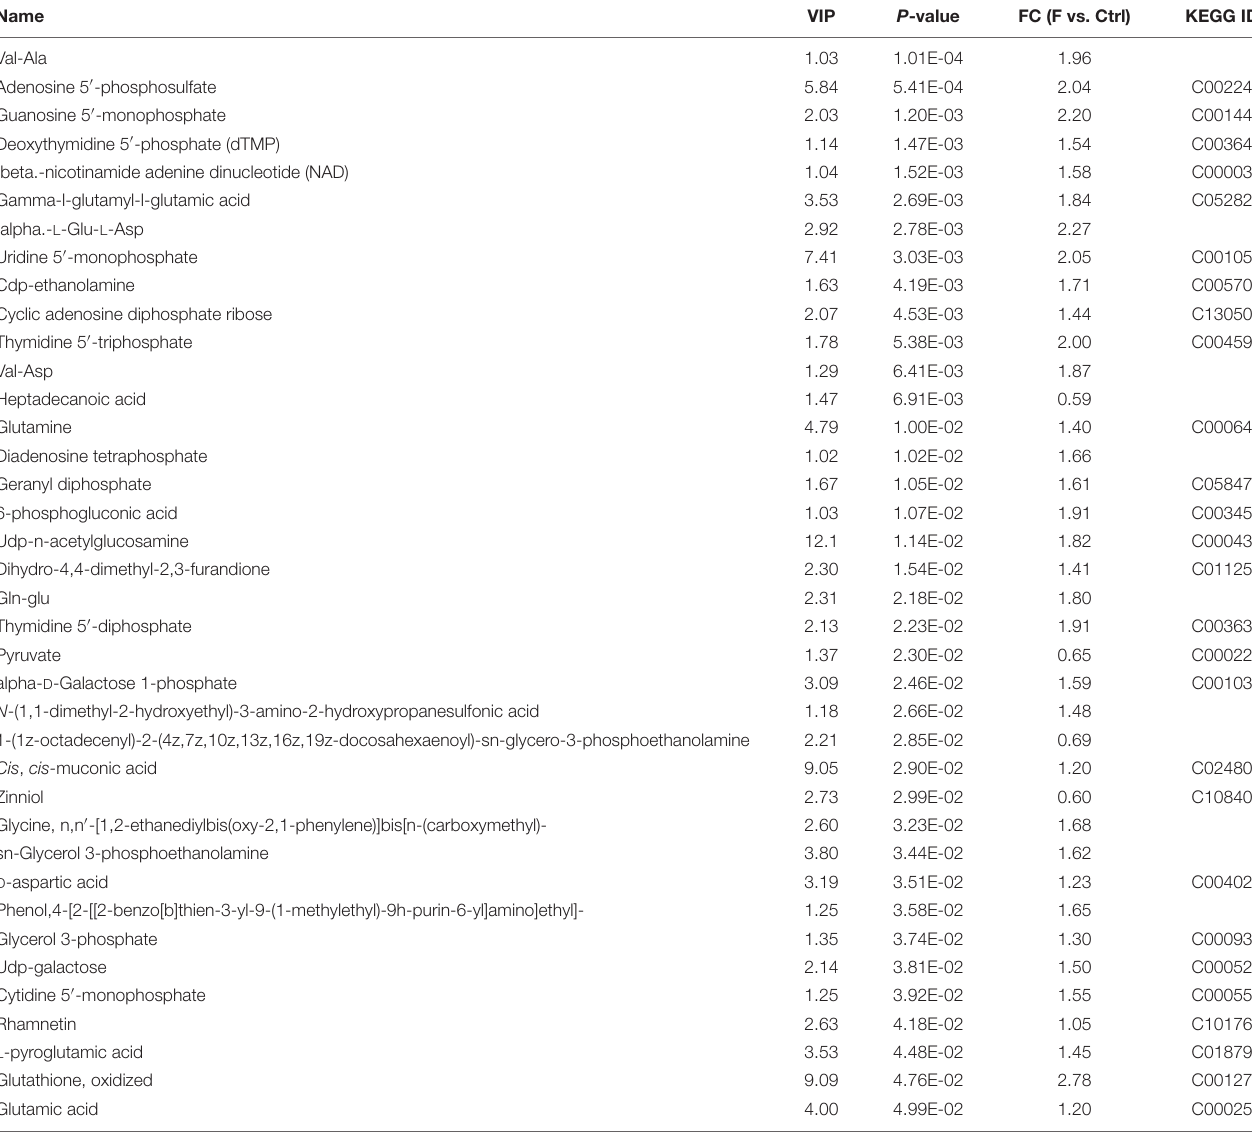
TABLE 2 | Differential metabolites in FAdV-4-infected LMH cells compared to controls in negative ion